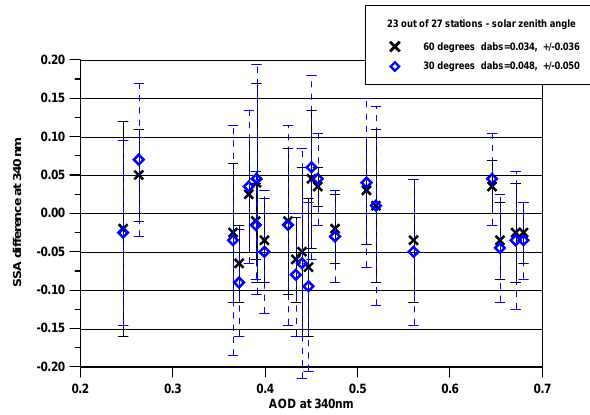
Figure 4: Results of SSA differences between each SP and the Qasume instrument for two solar Fig. 4. Results of SSA differences between each SP and the Qasume zenith angles as a function of AOD used for each station. instrument for two solar zenith angles as a function of AOD used for each